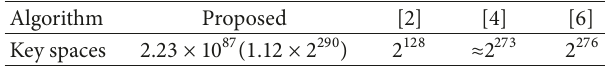
Table 5: Comparison of key